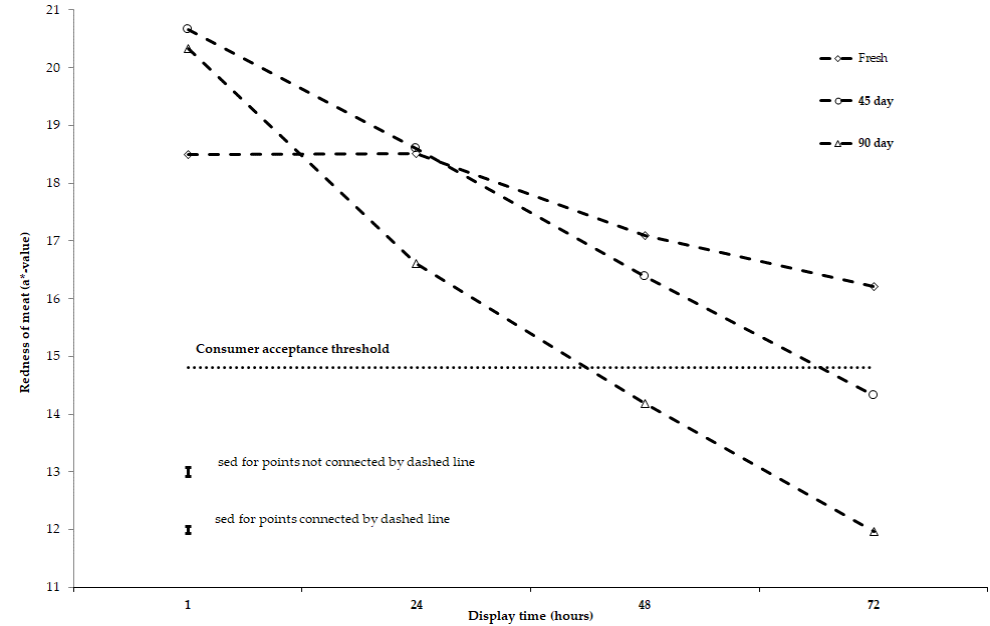
Figure 1. Effect of short-, medium-, and long-term storage (fresh, 45- and 90-day storage) on redness (a*-value) of muscle longissimus lumborum during 72 h of retail display under simulated refrigeration. Display time is the number of hours after muscle is cut and displayed for retail colour measurement. Sed denotes standard of difference.